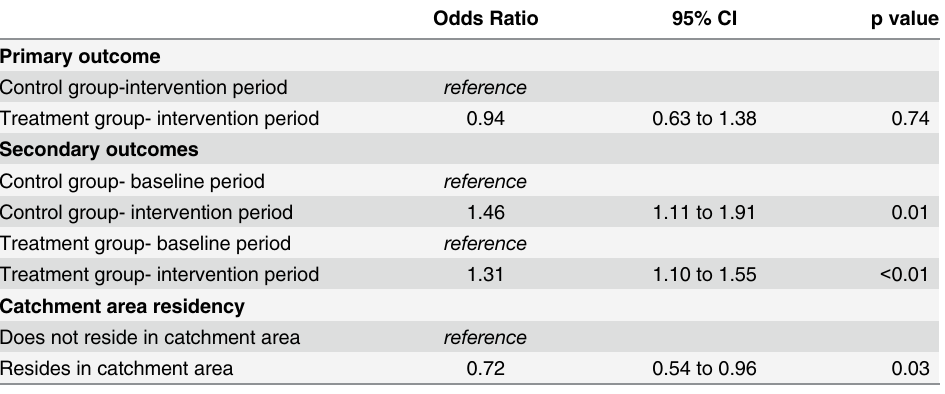
Table 4. Odds ratio by intervention periods and